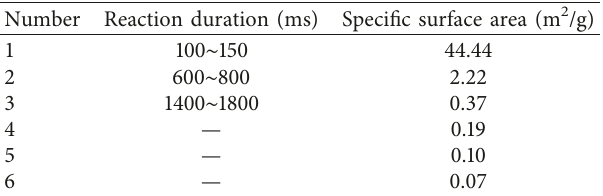
Figure 6: The states of specimens #1–#6 after quasistatic Table 2: The reaction duration and specific surface area of spec- imens #1–#6.